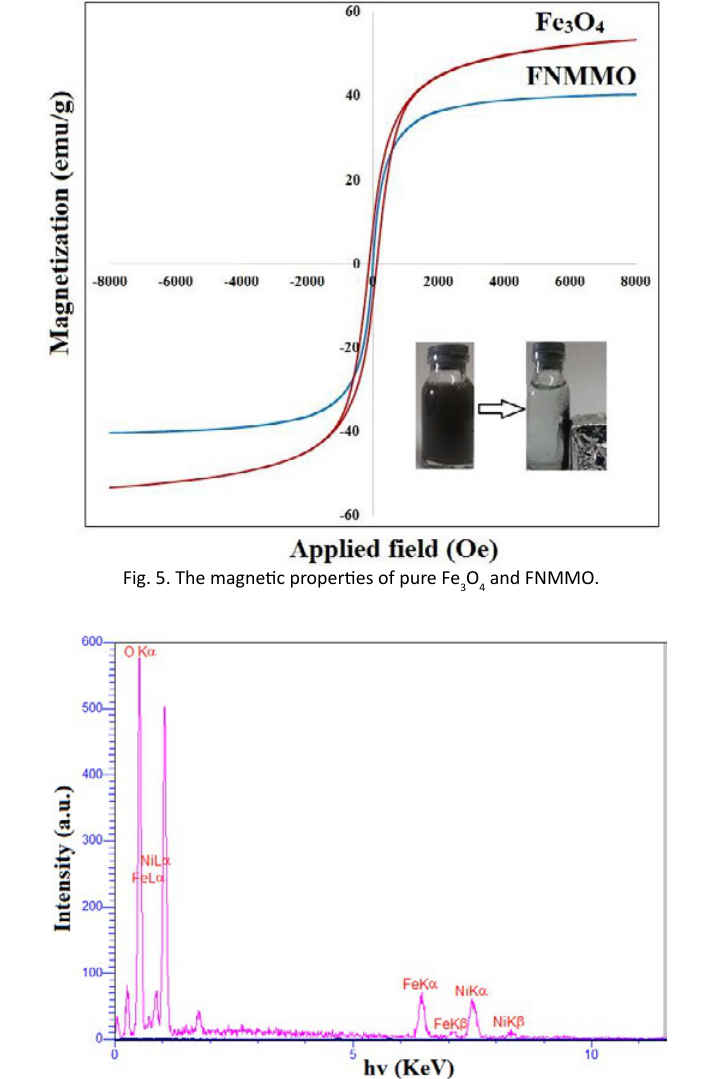
Fig. 6. EDX spectra of FNMMO